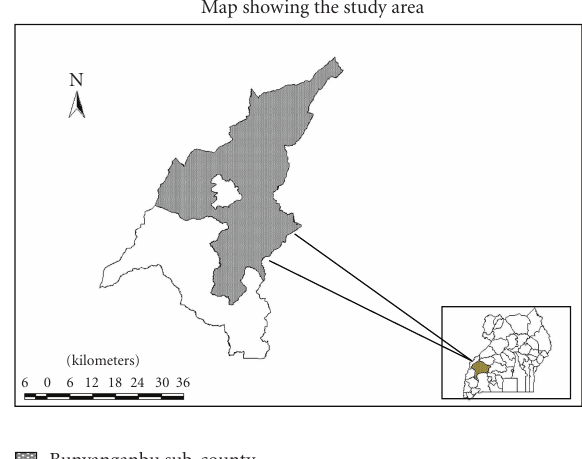
Figure 1: Bunyanganbu and Burahya sub-counties in Fort Portal district in